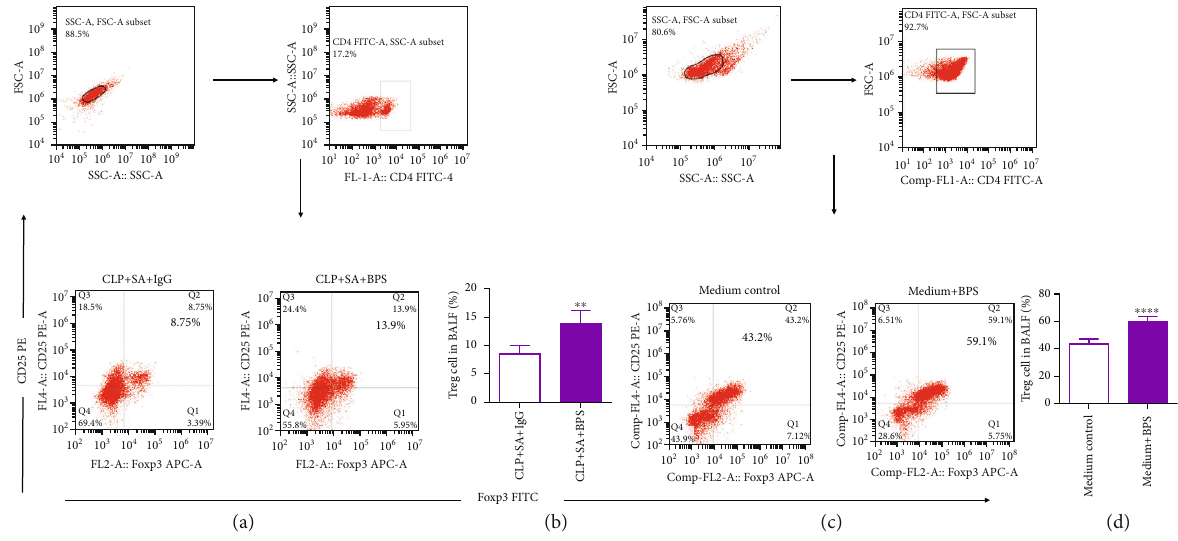
Figure 7: BPS promoted naive CD4 T lymphocytes to di ff erentiate to Treg cells. (a, b) We separated T cells from BALF of mice. CD4+CD25+Foxp3 Treg cell proportion was then measured through fl ow cytometric analysis, where the fi ndings indicated the means from 5 mice at each time point. (c, d) Treg proportion elevates relative to the nontreatment group following BPS challenge. ∗∗ p < 0 : 01 , ∗∗∗∗ p < 0 : 0001 , one-way ANOVA as well as LSD multiple comparisons test was conducted to compare two